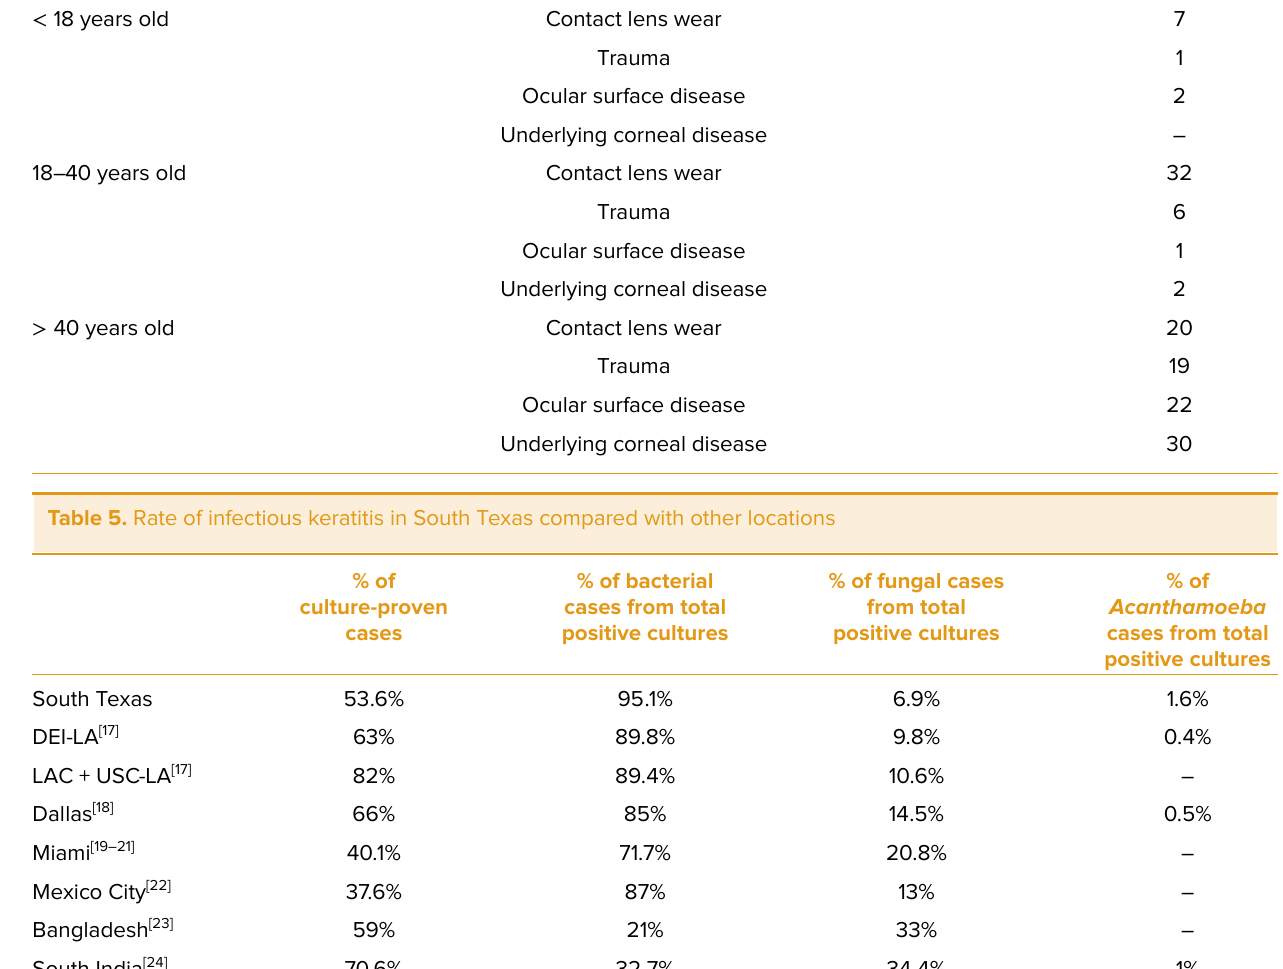
Table 4. Distribution of the four most common predisposing risk factors in different age subgroups Age Group